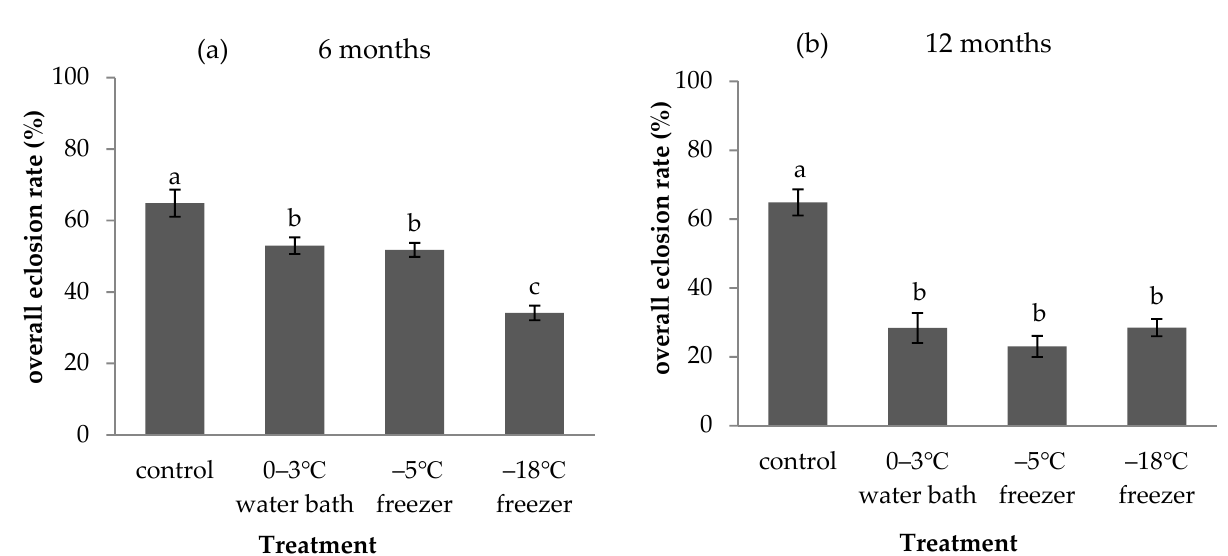
Figure 6. Overall eclosion rate of A. fulloi in A. pernyi eggs that were stored in low temperature for 6 months ( a ) and 12 months ( b ) (mean ± SE%). Control represents fresh eggs. Bars sharing the same letters are not significantly different (one-way ANOVA, followed by LSD multiple comparison tests, p < 0.05) between different treatments.